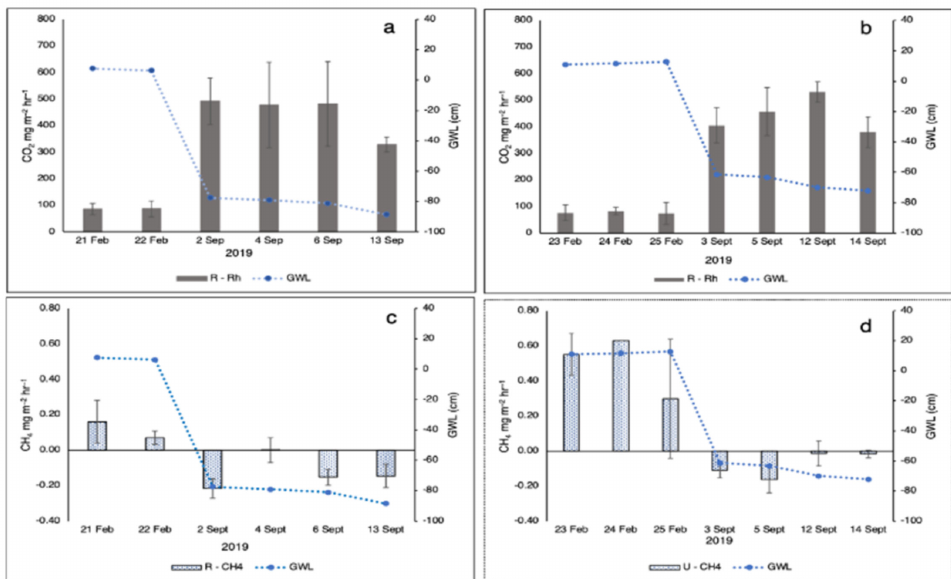
Figure 6. The fluctuation of R h and CH 4 at the rewetted ( a , c ) and undrained ( b , d ) sites. February 2019 represents the wet season and September 2019 represents the dry season. GWL is groundwater level, and R and U indicate rewetted and undrained sites. Errors are in